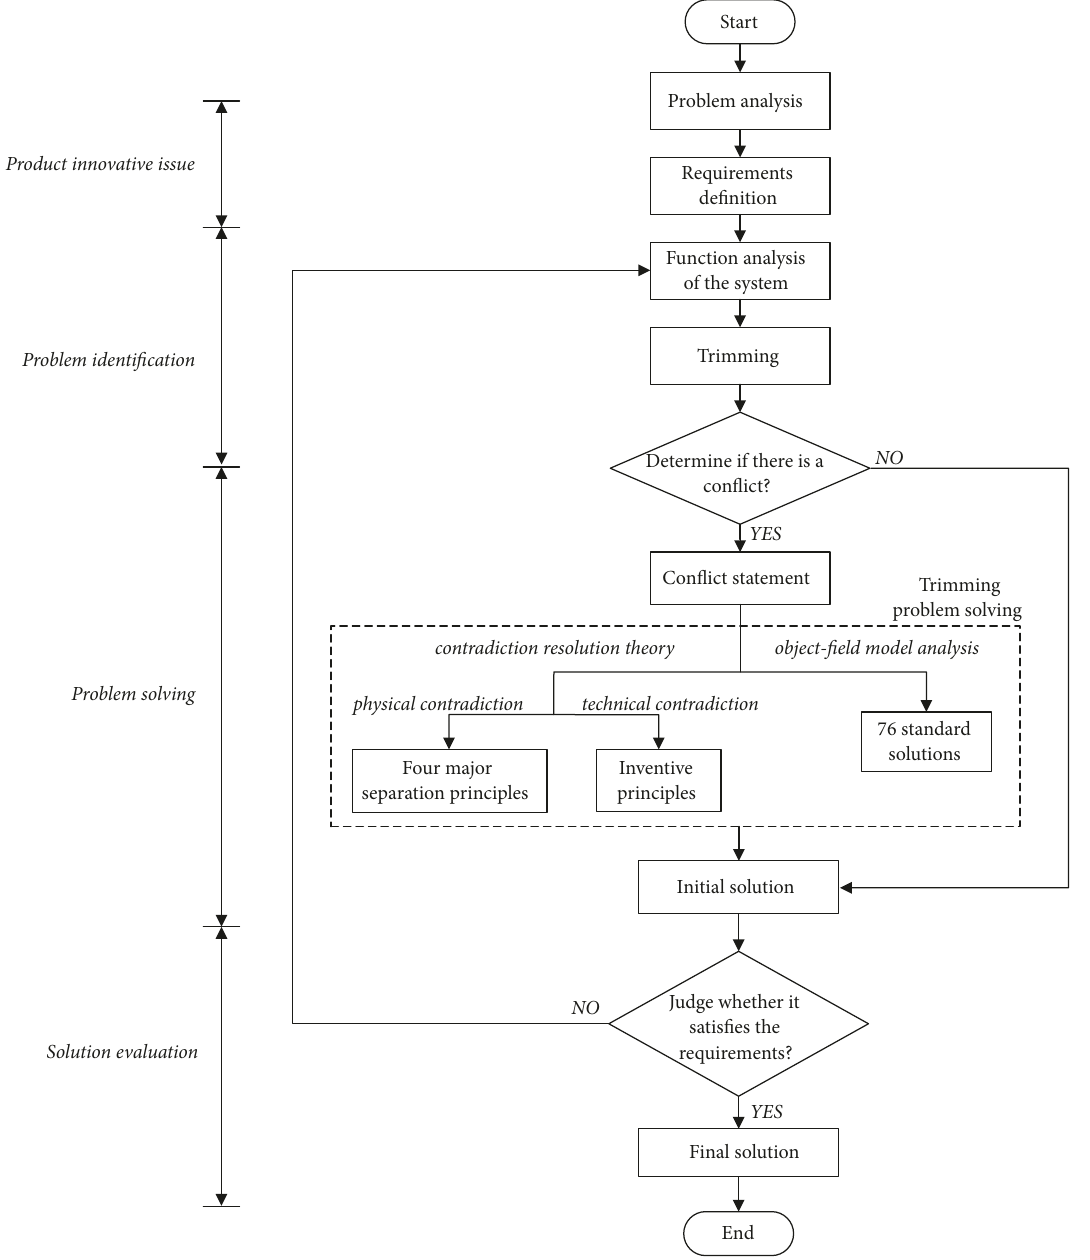
Figure 1: The trimming-based innovative design process